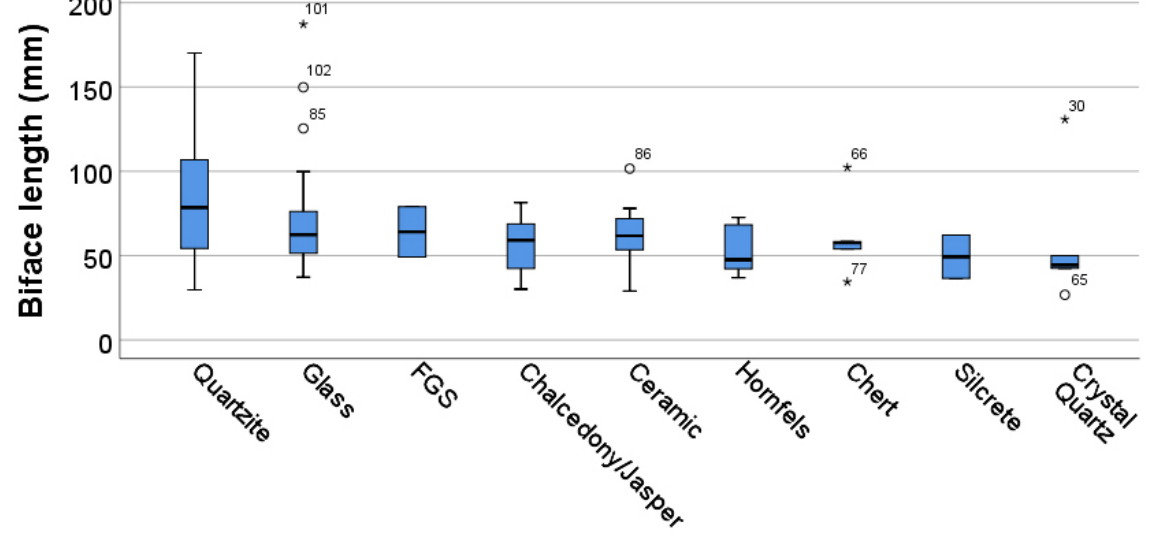
Figure 8. Biface length according to raw